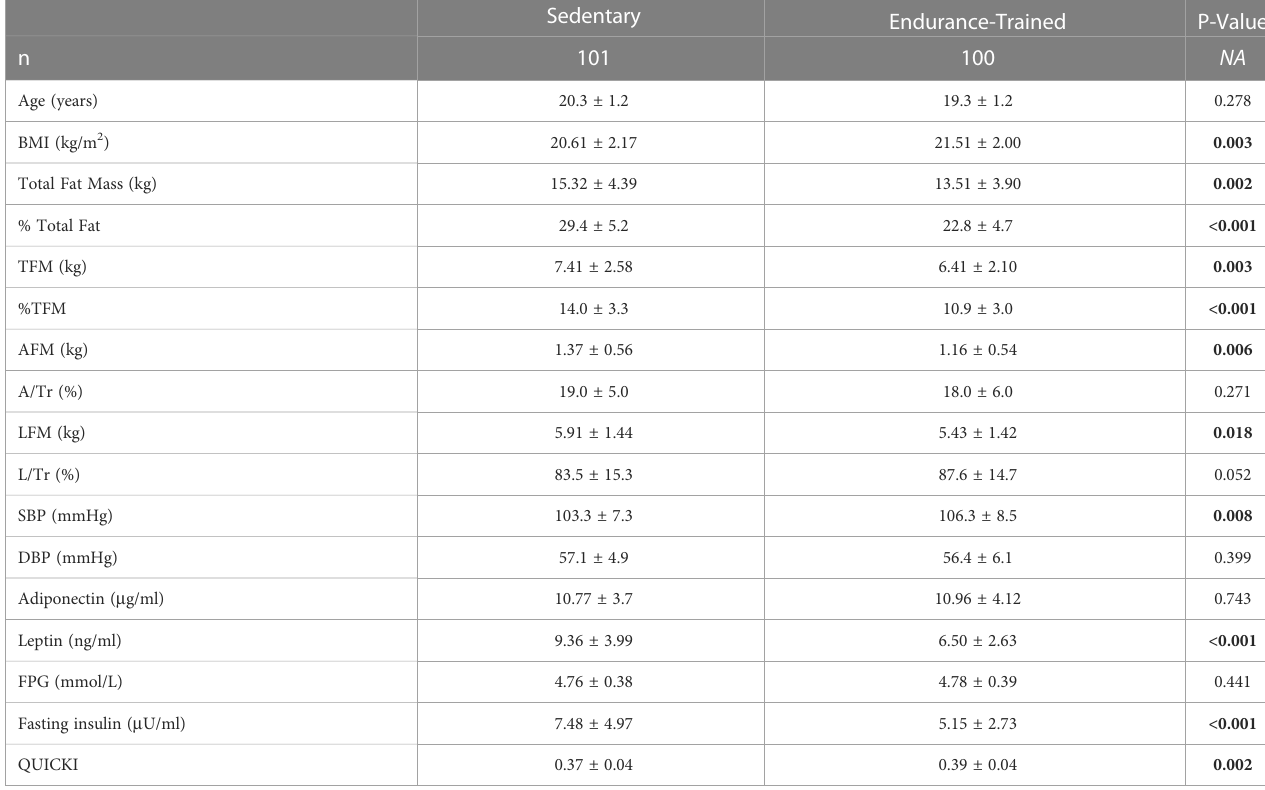
TABLE 1 Anthropometric, regional adiposity, and metabolic characteristics (X ± SD). Sedentary Endurance-Trained